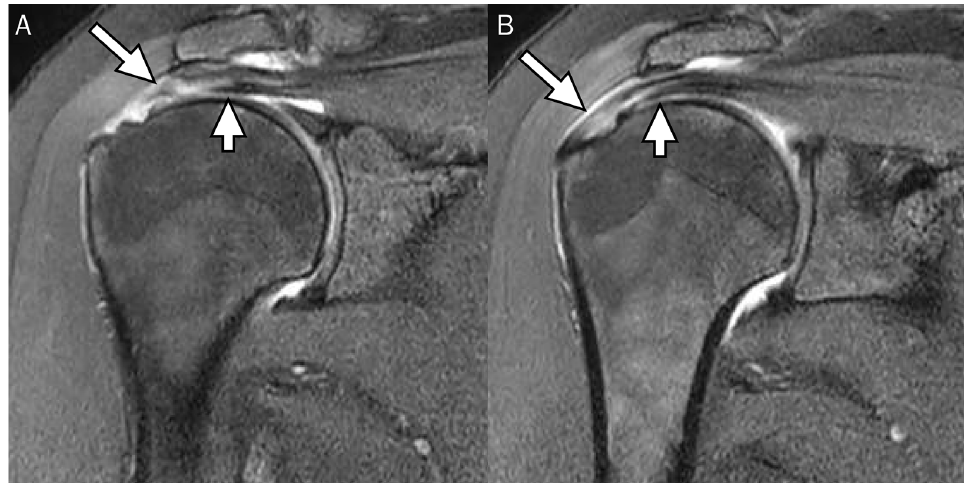
Figure 10. Articular-delaminated full-thickness and partial-thickness tear of the supraspinatus ten- don. ( A ) Oblique coronal fat-suppressed T2-weighted image at the mid-portion of the supraspinatus tendon shows an articular-delaminated full-thickness tear with a visible cleavage and ( B ) subsequent posterior image of coronal fat-suppressed T2-weighted image demonstrates an articular-delaminated partial-thickness tear with a visible cleavage. Note that the articular surface (short arrows) is retracted more medially than the bursal surface (long arrows).